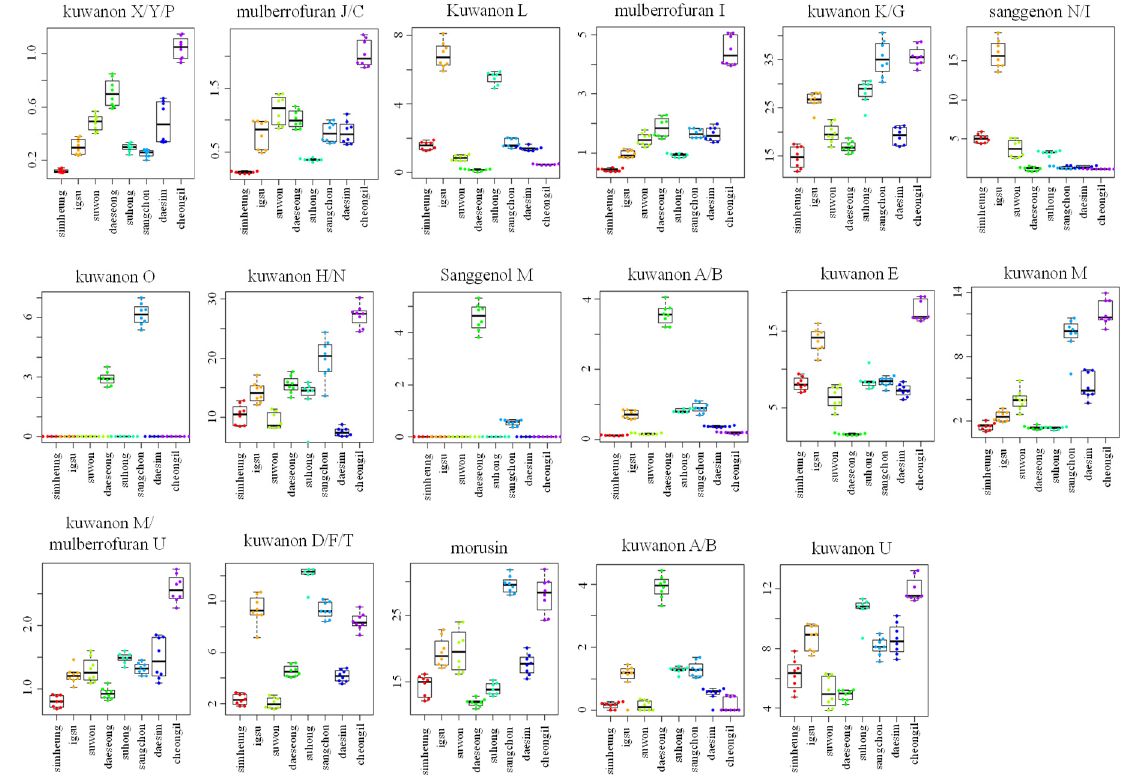
Figure 3. Box plot graphs of Morus roots with different cultivars ( Simheung , Igsu , Suwon , Daeseong , Suhong , Sangchon , Daesim , and Cheong-il ) for ESI-negative mode. Box plot graphs show the minimum, first quartile, median, third quartile, maximum, and outliers.